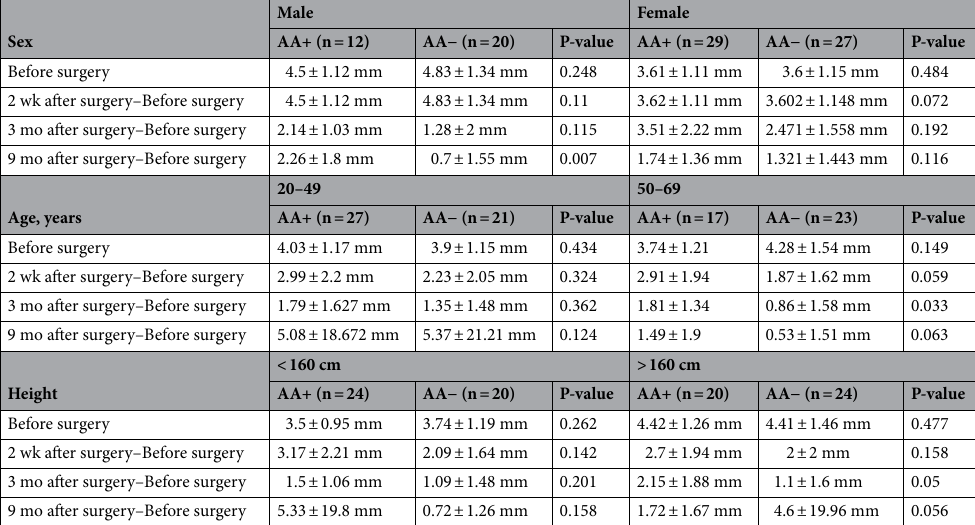
Table 3. Effects of sex, age, and height on the image marker distance in patients who underwent thyroidectomy with and without an anti-adhesion agent. AA+ with anti-adhesion agent, AA– without anti- adhesion agent, wk weeks, mo